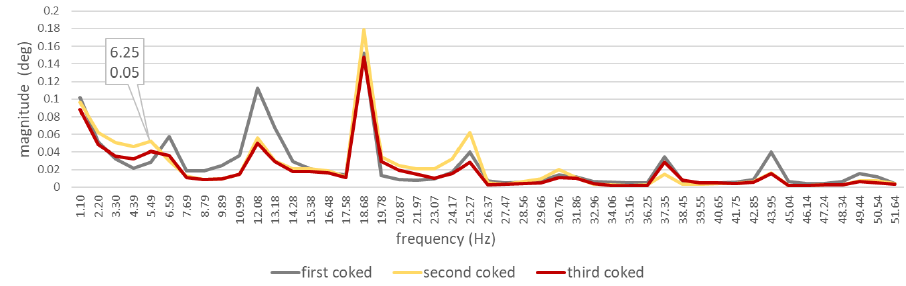
Figure 12. Mean value of torsional shaft vibration spectra. The diagram is limited to the 8th harmonic component only. Ship engine with a coked injector nozzle. Torsional vibration spectra of the DEU with a defective injector nozzle were different from those obtained for a defect-free engine (Figure 13): With the first injector nozzle defective, the largest differences in amplitude values were observed for seven harmonic components of the following orders: With the second injector nozzle defective, the largest differences in amplitude values were observed for twelve harmonic components of the following orders: